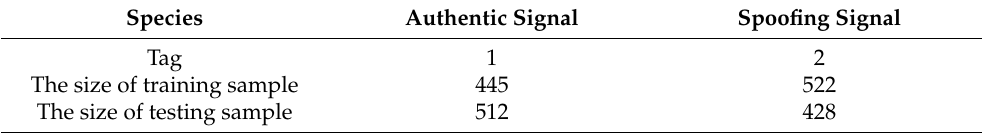
Table 1. Sample data settings.